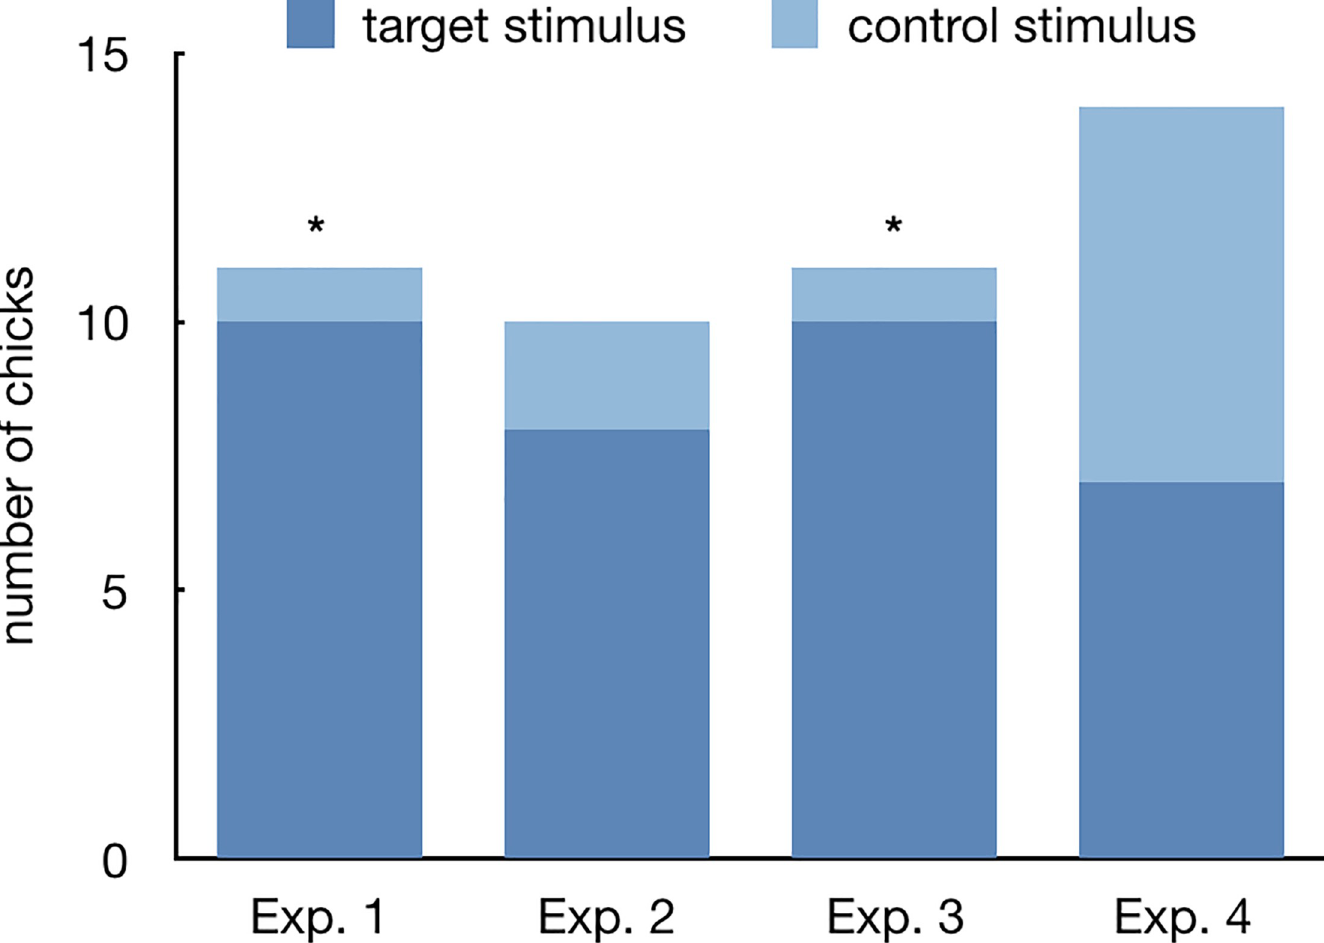
Fig 2. Absolute preference. Number of chicks (Y axis) showing an absolute preference for the target or the control stimulus (in dark and light blue, respectively), plotted for each experiment. Asterisks ( � ) represent significant departures from a random distribution (p < 0.05).